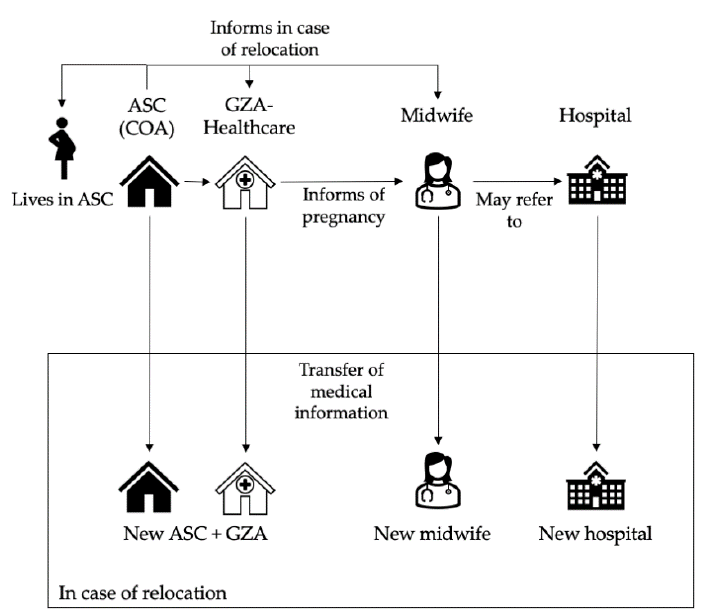
Figure 1. Organization of antenatal care and relocations of pregnant asylum seekers in The Netherlands. ASC = asylum seekers center; COA = Central Agency for the reception of Asylum seekers; GZA = GZA Healthcare (health care center of contracted primary care provider for asylum seekers).